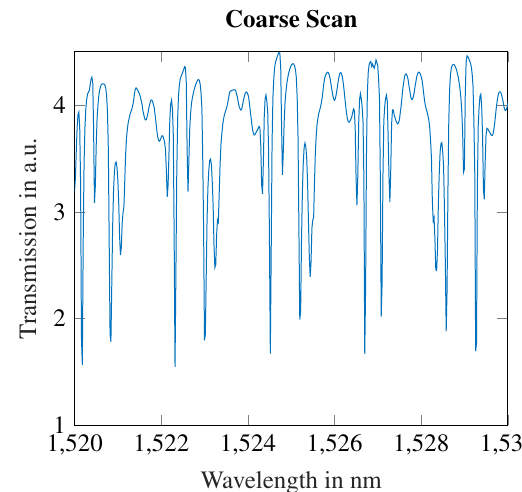
Figure 4: Measured resonances by monitoring the trans- mission of a tapered single mode